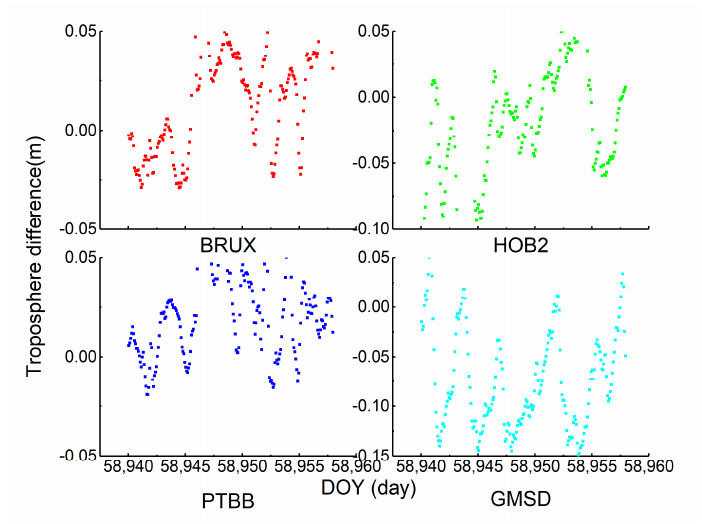
Figure 7. The time series of zenith path delay parameters (ZPD).